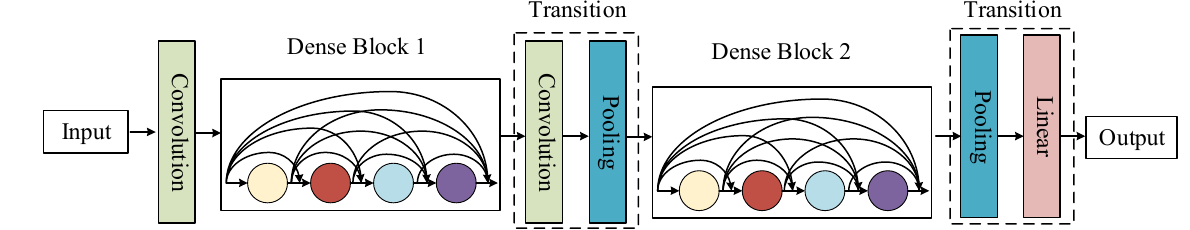
Figure 3. DenseNet model diagram.